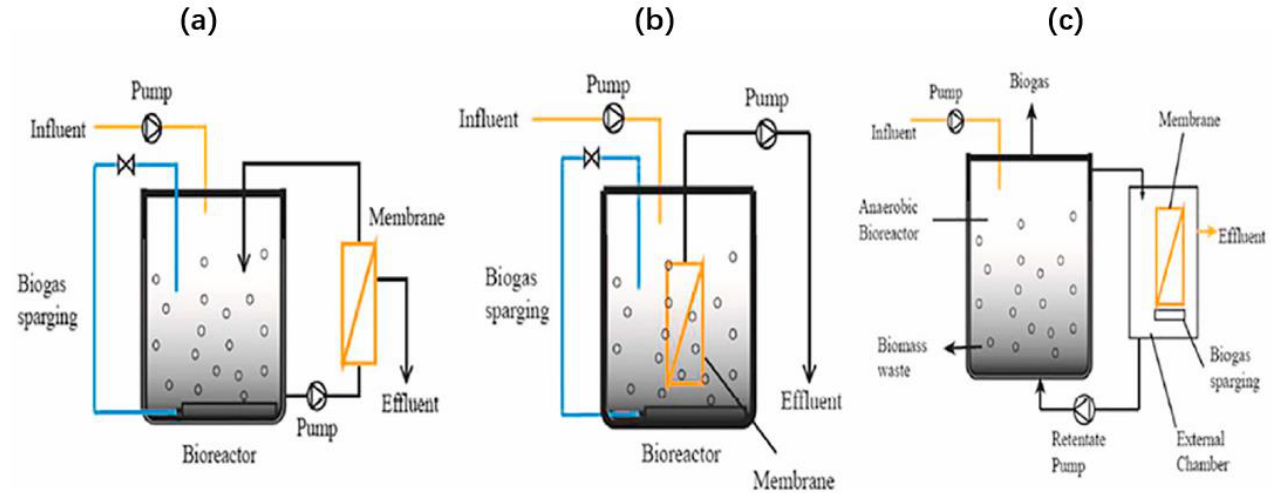
Figure 7. Basic configuration of an anaerobic membrane bioreactor: ( a ) flow measurement; ( b ) internal submerged; ( c ) external submerged (Reprinted with permission from Ref. [170] Al-Asheh et al., 2021).